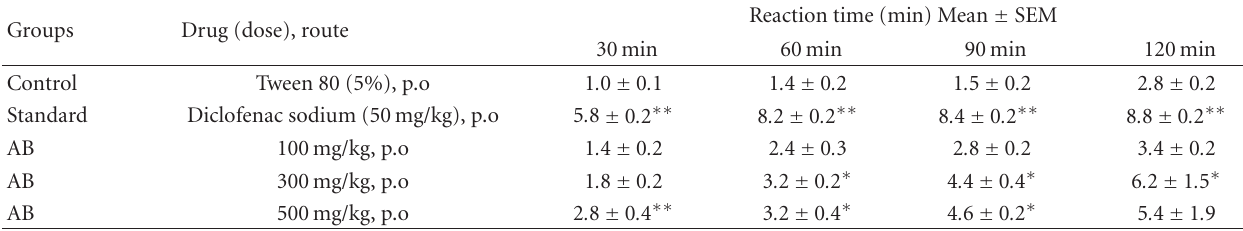
Table 4: Protective efeect of Pinus roxburghii Sarg. on tail withdrawal reflex induced by tail immersion. Groups Drug (dose), route